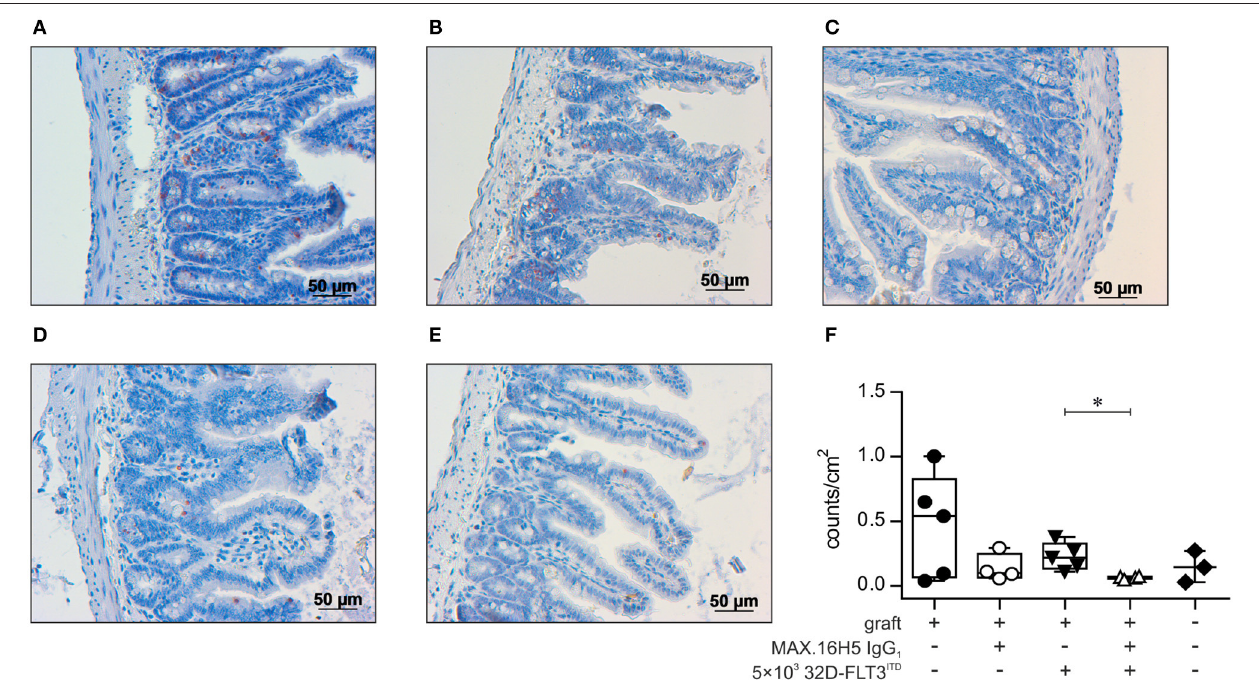
FIGURE 5 | Histological analysis of gut tissue (ileum) from transplanted animals by TUNEL assay. Histological sections of gut tissues from all C3H/HeN mice receiving 1 × 10 7 bone marrow cells (BMC) and 3 × 10 7 splenocytes (SpC) after pre-incubation with MAX.16H5 IgG 1 or an untreated graft with or without co-transplantation of 5 × 10 3 32D-FLT3 ITD cells were examined regarding apoptotic cell count. NaCl treated mice served as the control group. Five individual visual fields from one histological slide of the gut of each mouse were randomly chosen and microscopically recorded in 10 × magnification, and apoptotic cell counts were analyzed with ImageJ. (A–E) Representative histological ileum images of the transplanted animals (magnification 20 × ) after TUNEL staining. TUNEL stained gut sections of animals receiving 1 × 10 7 bone marrow and 3 × 10 7 spleen cells (A) without antibody pre-incubation and (B) with MAX.16H5 IgG 1 pre-incubation are shown. (C) Ileum TUNEL staining from one mouse receiving a non-incubated graft together with 5 × 10 3 32D-FLT3 ITD cells. (D) Histological section from one mouse receiving a MAX.16H5 IgG 1 pre-incubated graft together with 32D-FLT3 ITD AML cells. (E) TUNEL staining of a gut section from a NaCl control animal. Red areas indicate apoptotic nuclei in the basal crypts of the mucosa, which are a diagnostic criterion in acute GVHD ( 80). Apoptotic nuclei in the apical mucosal layer were excluded from the analysis. (F) Group-separated boxplots indicating the group medians and quartiles together with each symbol representing the mean of the examined apoptotic nuclei count per cm 2 (based on the image in 10 × magnification) of all counted visual fields per mouse. Wilcoxon rank sum tests on unprocessed data were used for comparative statistics. * P <